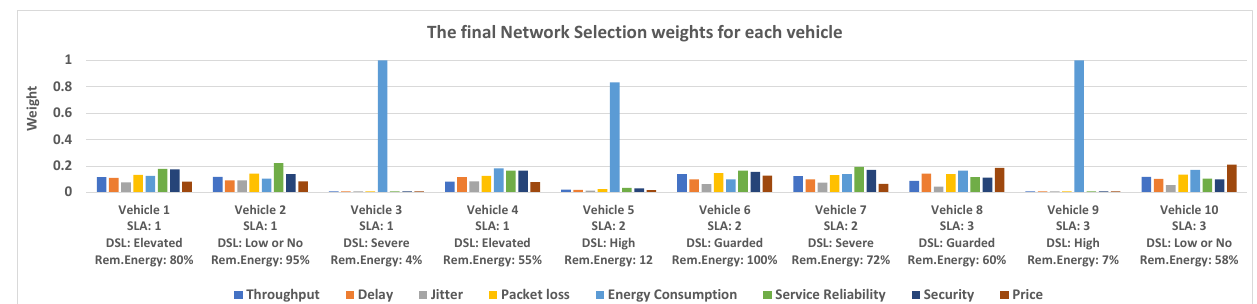
Figure 19. The importance of the energy consumption factor.